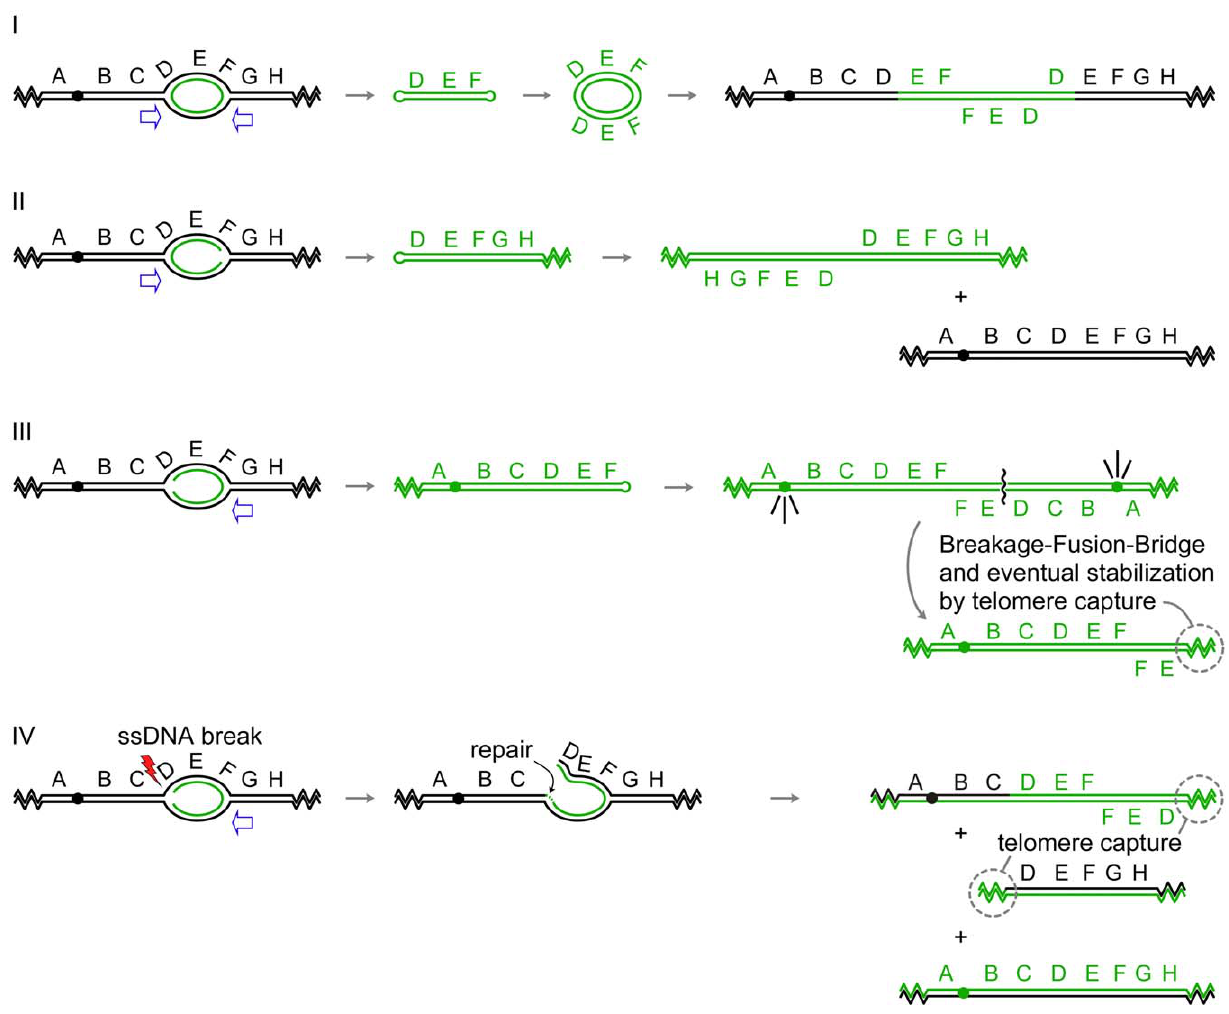
Figure 3. Palindrome formation and resolution by ODIRA generates a range of amplification products. In each of the examples I–IV, initiation of replication from an origin near the sequence labeled E generates bidirectional forks that have progressed through the flanking sequences D and F. In the four scenarios depicted, either one or both of the replication forks becomes ‘‘closed’’ by ligation of the leading strand to the lagging strand. Open arrows indicate the direction that flanking replication forks move to expel the ‘‘closed’’ fork intermediate by branch migration. (I) In this example, both forks ‘‘close.’’ Replication forks approaching from either direction (open arrows) will release the hairpin-capped linear that contains genes D, E, and F. Subsequent replication of this ‘‘dog bone’’ molecule generates a dimeric, palindromic circular molecule that can reintegrate through homologous recombination into the original chromosome, or into a homolog if one is present, or by random integration elsewhere in the genome. These steps are described in detail in Figure 2. (II) In this example, the fork closest to the centromere ‘‘closes’’ while the telomere proximal fork remains active, fusing with distal replicons to allow replication of segments G, H, and the right telomere. The fork moving outward from the centromere (open arrow) will dislodge a fragment that has a hairpin at one end and a telomere at the other. Subsequent replication results in an isochromosome containing genes D–H. These acentric chromosomes are relatively stable in yeast [30,32], and in human cells stability can be improved by the acquisition of a neocentromere [52] or by chromosome tethering [53,54]. (III) In this example, only the distal fork closes. Completion of replication by a fork from the telomere proximal side of the closed fork releases a similar intermediate as in (II). Replication of the fragment with a hairpin near gene F generates an isochromosome that contains the centromere and genes A–F. Cycles of BFB will occur until the break is healed by the addition of a telomere. (IV) This example begins as the one in (III); however, the fork near gene D suffers a ssDNA break. Repair of this break by ligation of the broken strand to the nascent strand generates a branched intermediate that can be resolved by a fork moving in from the region of genes G and H. Two aberrant chromosome fragments are generated by this resolution, both requiring telomere addition to become resistant to nucleases. The fragment containing the centromere is an ‘‘inv dup del’’ chromosome indistinguishable from a chromosome generated by BFB (III). The fate of the acentric fragment is expected to be similar to that of an acentric isochromosome.